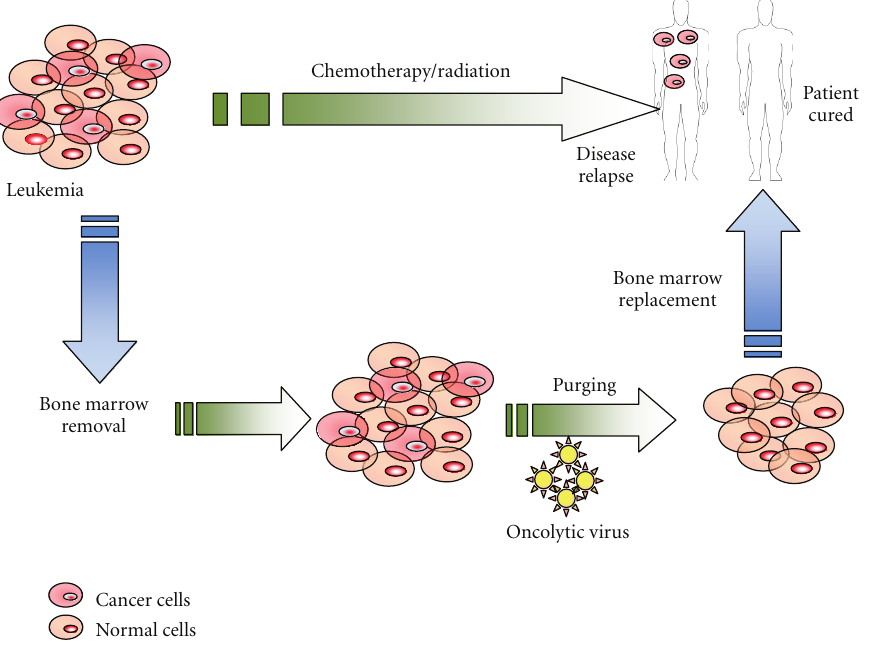
Figure 1: Proposed treatment schema of oncolytic virotherapy for patients with hematological malignancies undergoing high-dose chemotherapy and autologous HCT.